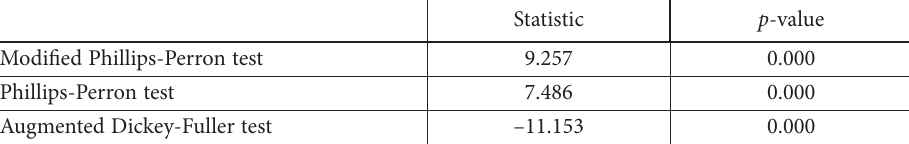
Table 4. Pedroni cointegration test for 2018–2020 model (source: compiled by the author)